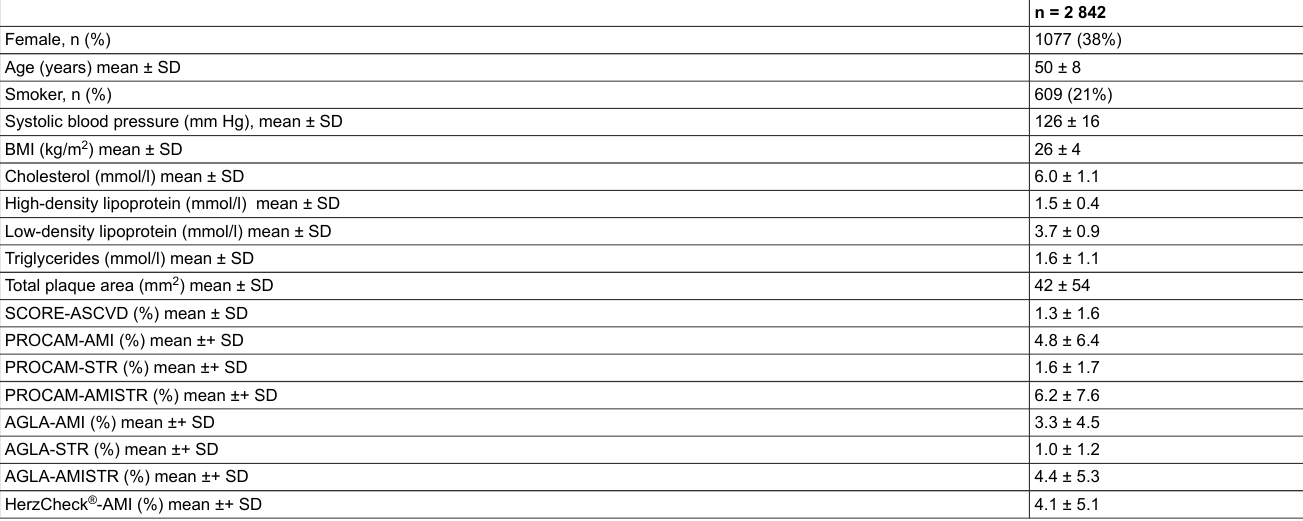
AGLA: national working group on lipids and atherosclerosis of the Swiss Society of Cardiology; AMI: fatal and nonfatal myocardial infarction; ASCVD: atherosclerotic cardiovas- cular disease; BMI: body mass index; PROCAM: Prospective Cardiovascular Münster Study for fatal and non-fatal myocardial infarction; SD: standard deviation; STR: